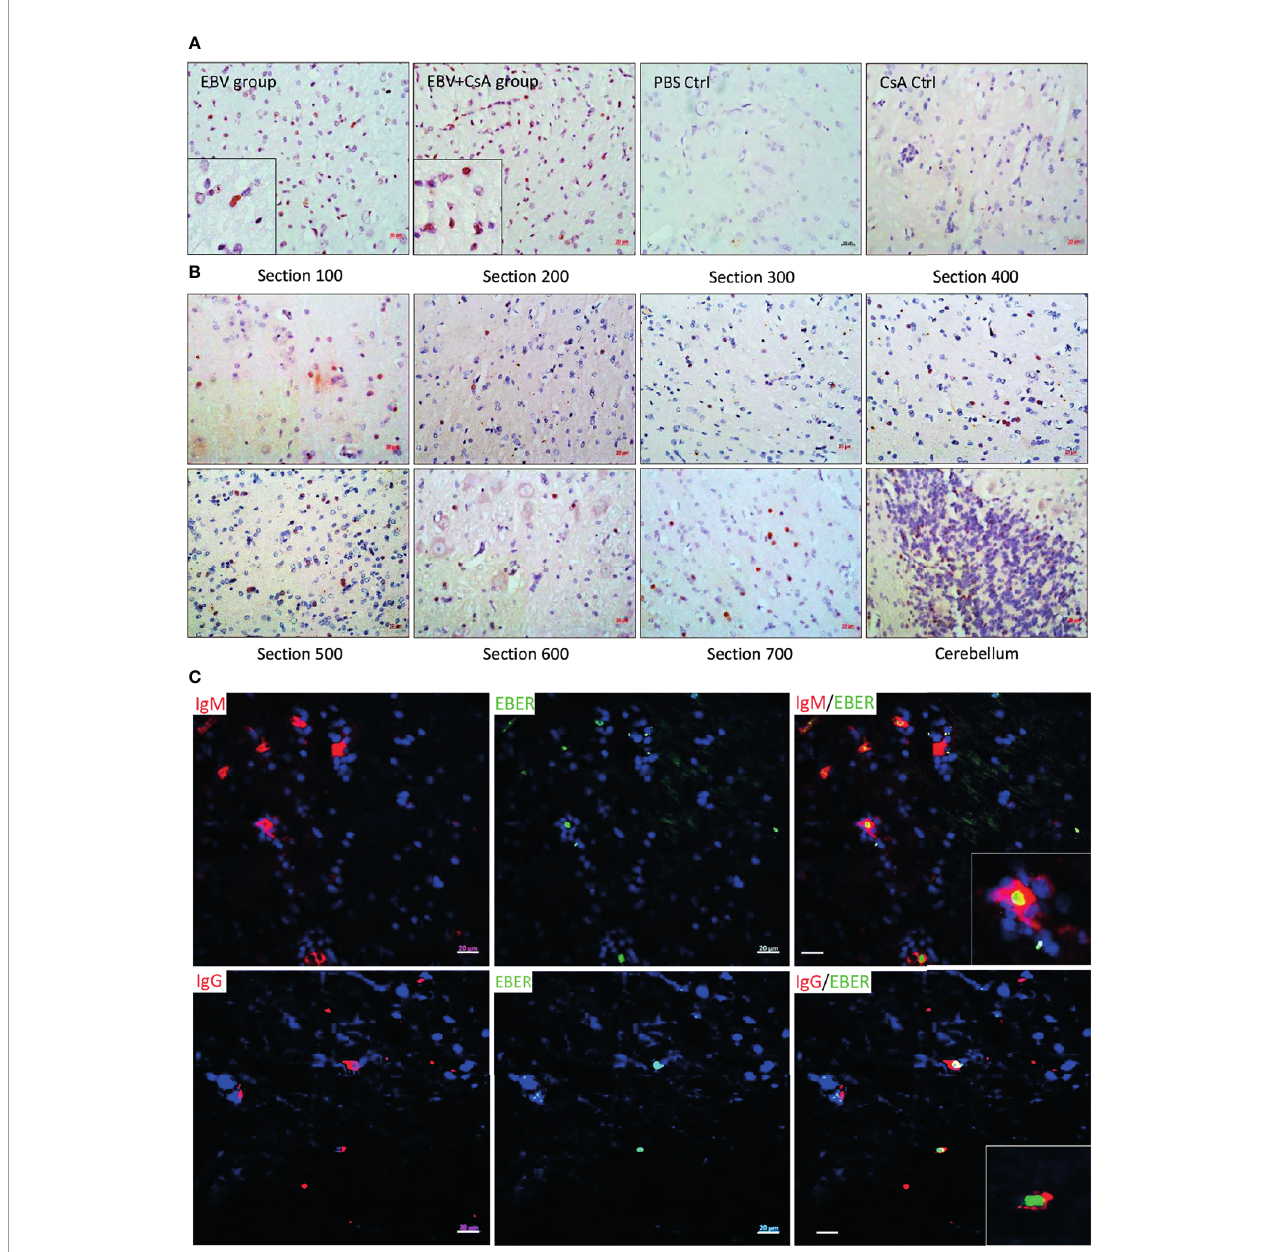
FIGURE 6 | EBV infected cells in fi ltrated the brain. (A) Representative images of EBER-ISH on brain sections from EBV and EBV+CsA groups and their corresponding PBS/CsA controls. Scale bar=20µm. (B) Immunohistochemistry for EBNA1 in a series of sections from a heavily infected cerebral hemisphere and cerebellum. Scale bar=20µm. (C) Double staining for IgG/IgM (red) and EBERs (green) to determine the phenotype of infected cells in the brain. Scale